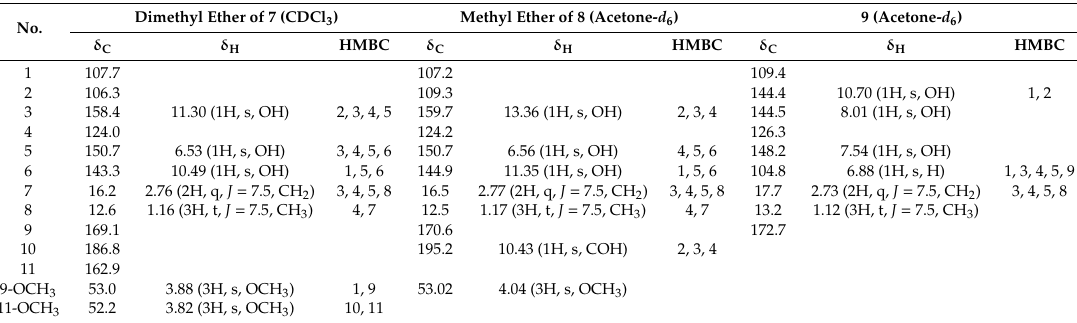
Table 3. NMR data of dimethyl ether of compound 7 (500 MHz for 1 H and 126 MHz for 13 C, δ , ppm, J / Hz), methyl ether of compound 8 , and of compound 9 (700 MHz for 1 H and 176 MHz for 13 C, δ , ppm, J /